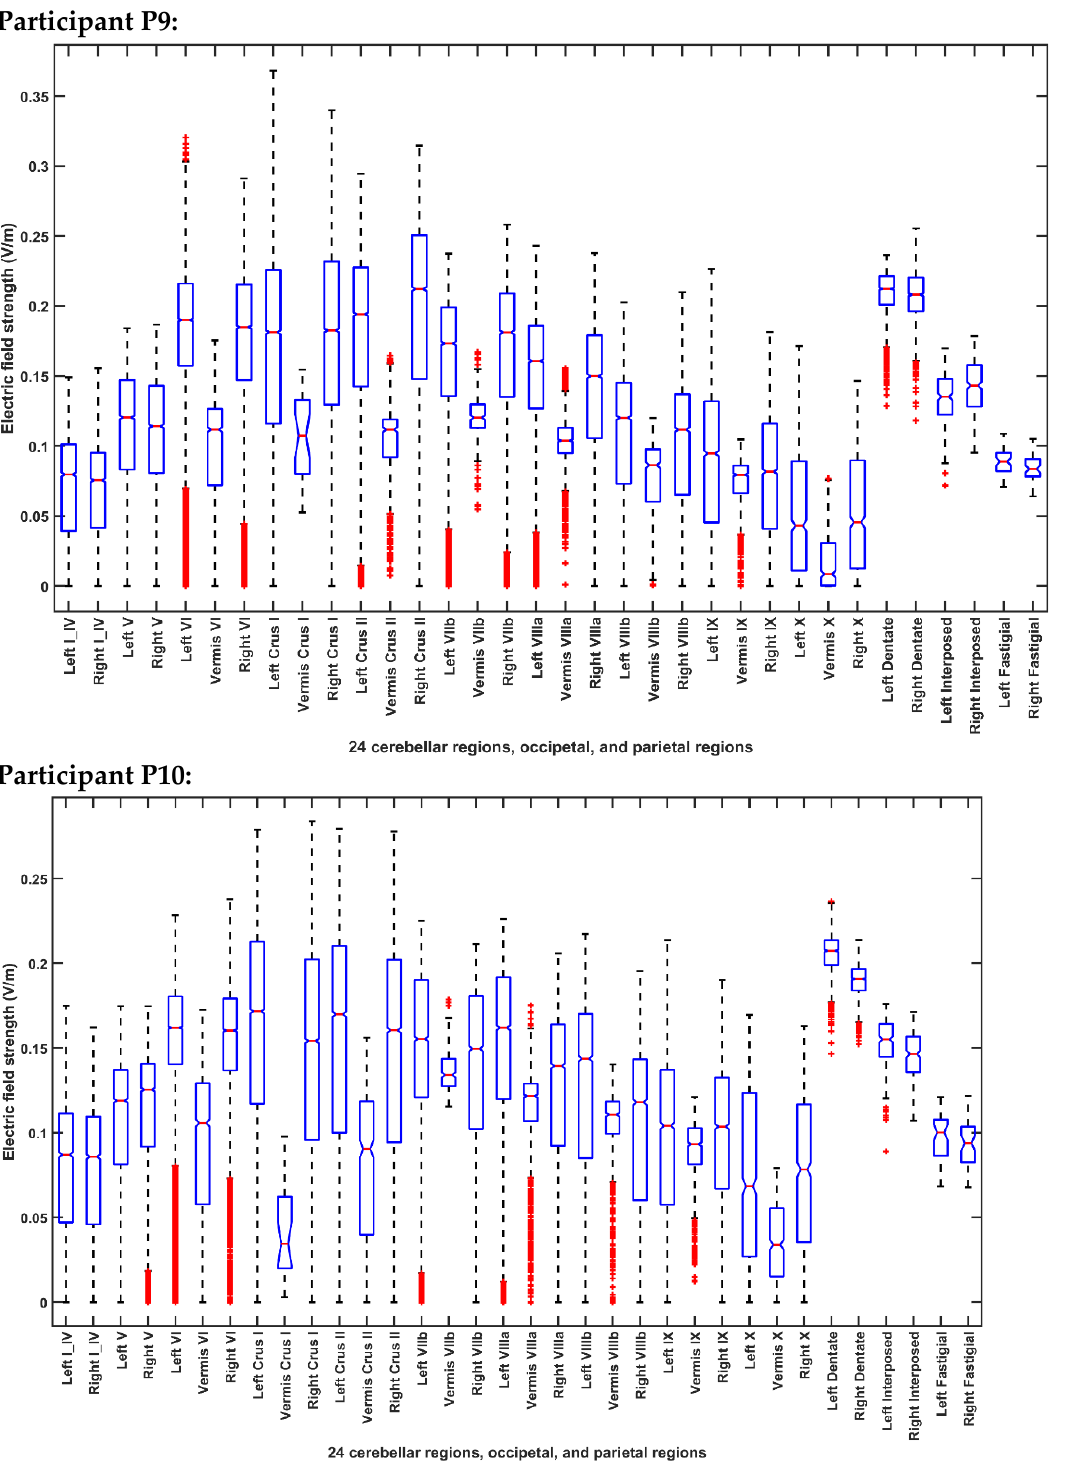
Figure 5. Boxplot of the lobular electric field distribution for the 10 post-stroke patients for the PO9h–PO10h montage for case 1 (optimization for dentate nuclei).